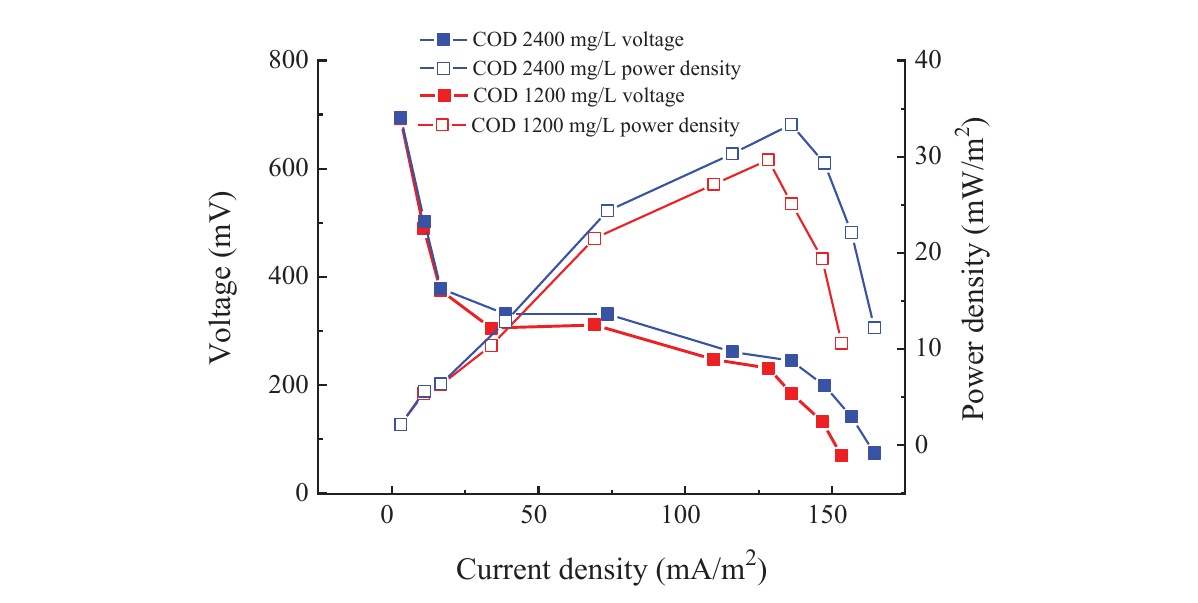
FIGURE4 Power density and polarization curve of the revolving algae-bacteria biofilm cathode in a photosynthetic membrane-free microbial fuel cell (RAB-MFC)